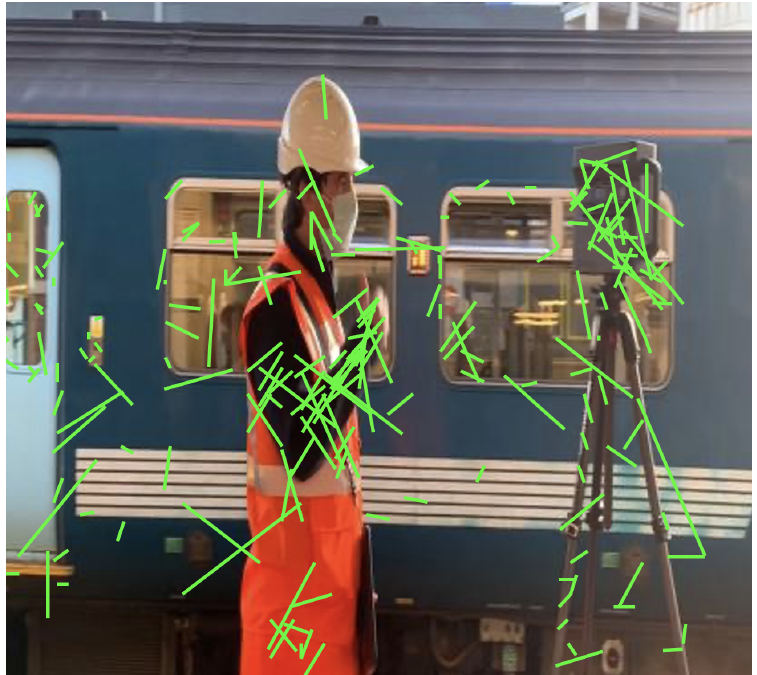
Figure 9. Experimental results of Lucas Kanade Optical flow method. Optical flow at high or normal wavelength is represented by the green line, while optical flow at low wavelength is represented by the green